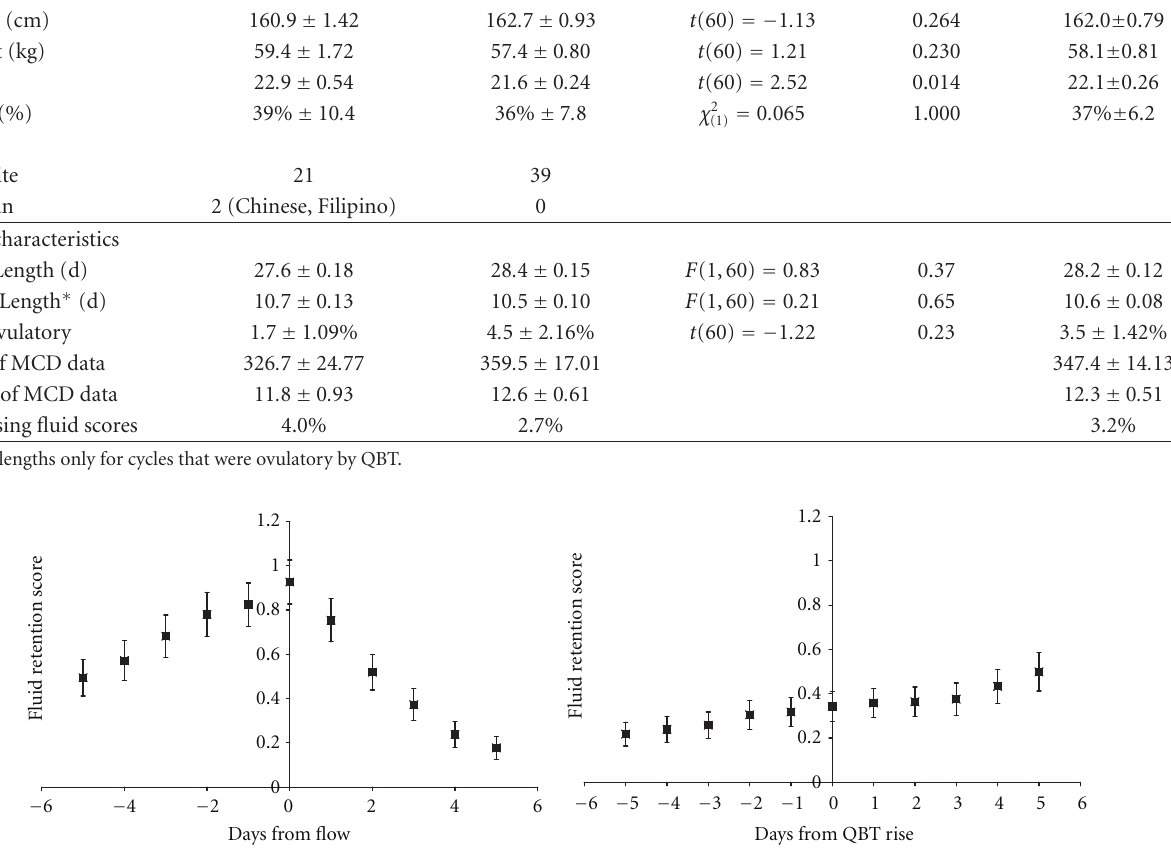
Figure 1: Fluid retention scores (range: 0–4) in 62 initially ovulatory women across one year by menstrual cycle day relative to (a) the onset of menstrual flow ( n = 765, 12 . 3 ± 0 . 51 cycles per woman), where 0 is the first day of flow, and (b) in ovulatory cycles only ( n = 717, 11 . 6 ± 0 . 54 cycles per woman), where 0 is the first day of elevated basal temperature (denoted QBT rise) as estimated by the validated quantitative basal temperature algorithm (QBT). To correct for di ff erences in the duration of data collection by women, data are presented as the average (bars ± standard error of the mean) of within-woman averages. Fluid retention was scored from 0–4 using the daily Menstrual Cycle